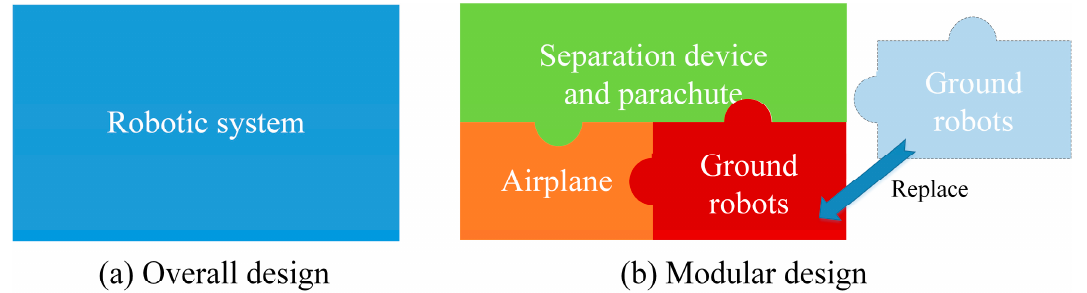
Figure 7. Overall design and modular design of the MSADM.